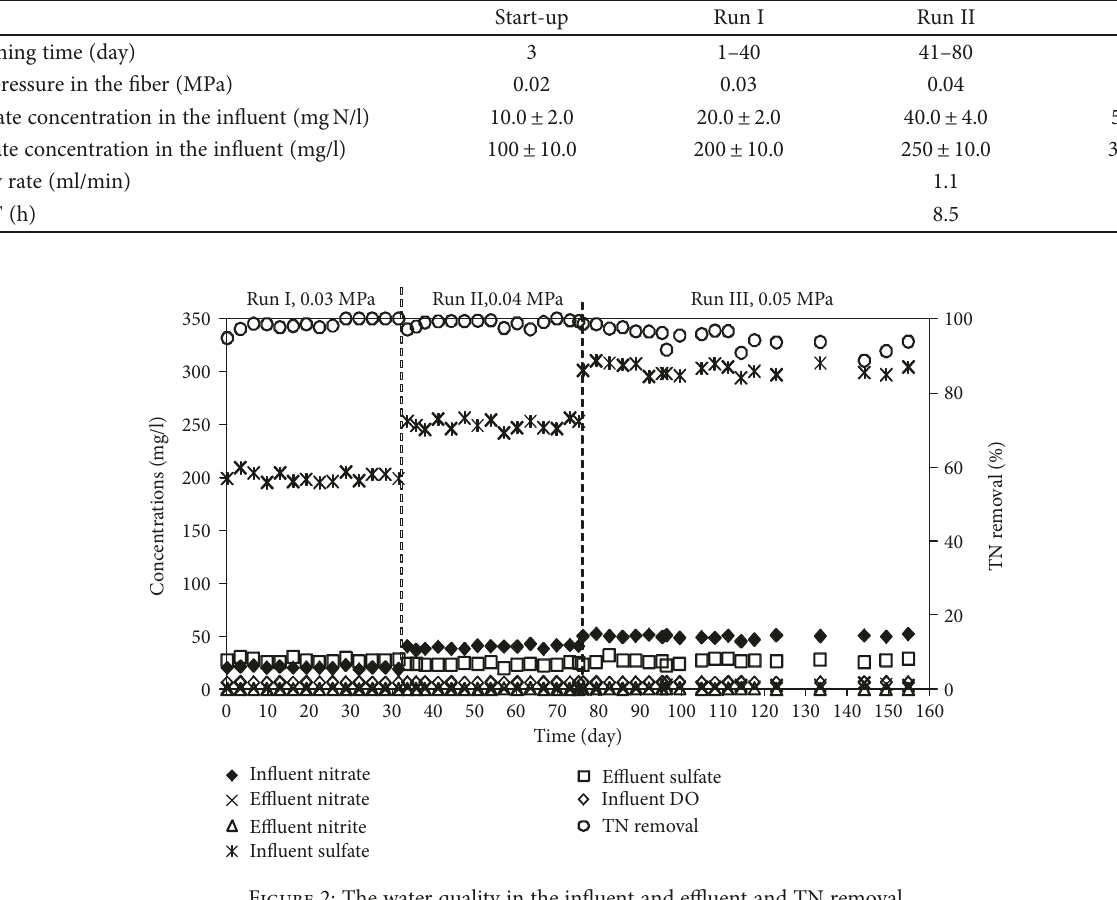
Figure 2: The water quality in the in fl uent and e ffl uent and TN